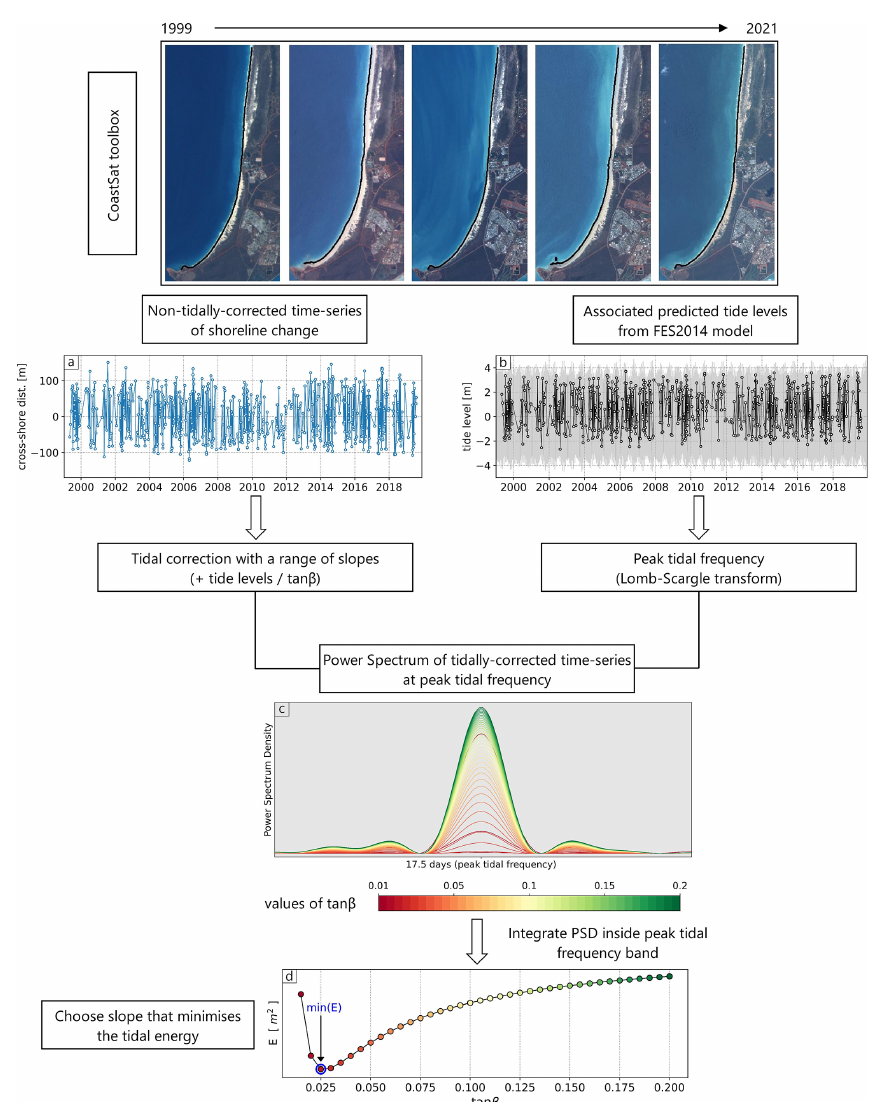
Figure 2. Flowchart of the methodology used to estimate beach-face slopes from satellite-derived shorelines and predicted tides, as described in Vos et al. (2020). Firstly, instantaneous shorelines are mapped onto Landsat imagery with the CoastSat toolbox. The time series of non- tidally corrected shoreline change (a) and their associated tide levels (b) are then combined in the frequency domain to find the slope that, when used for tidal correction, minimises the tidal signal. Panel (c) shows the power spectrum density (PSD) of the tidally corrected time series, demonstrating how the slope value modulates the energy inside the tidal frequency band, which is plotted as a function of slope in (d)